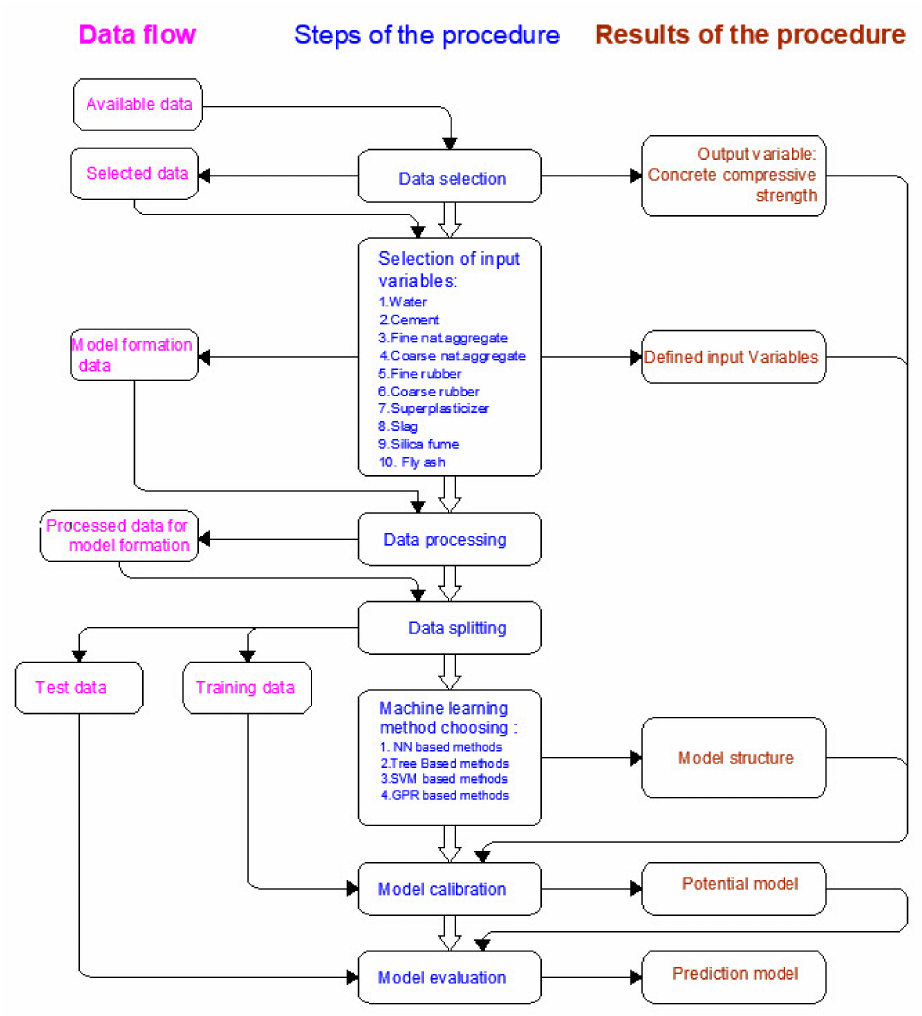
Figure 6. Systematic approach in forming prediction